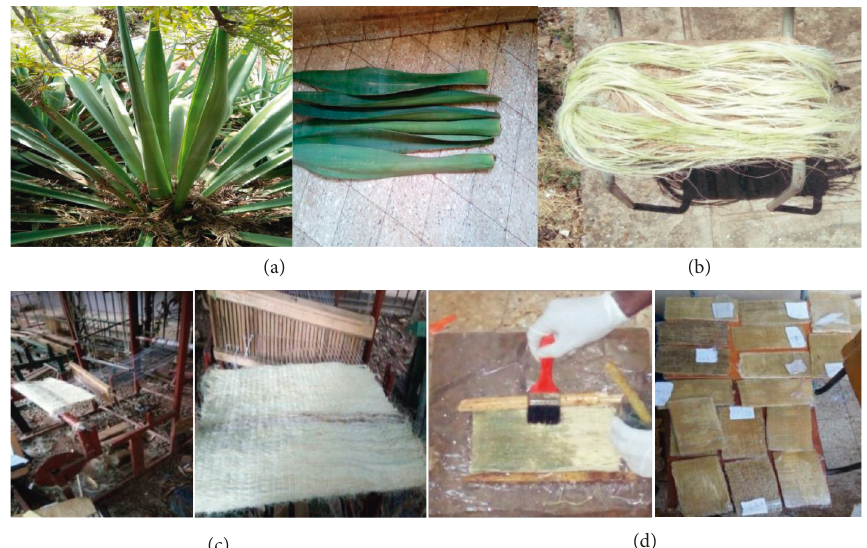
Figure 1: Fabrication of specimen composite material. (a) Sisal plant leaves, (b) extracted sisal fiber, (c) handloom machine and fabricated mat, and (d) laminated via polyester and prepared specimens.